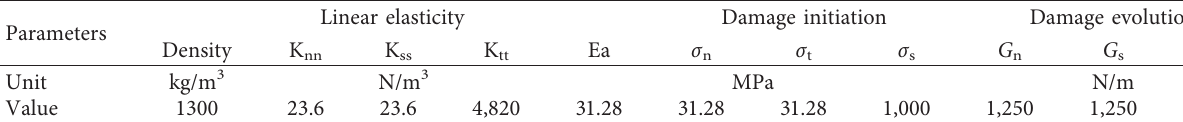
Table 2: Mechanical properties of adhesive material